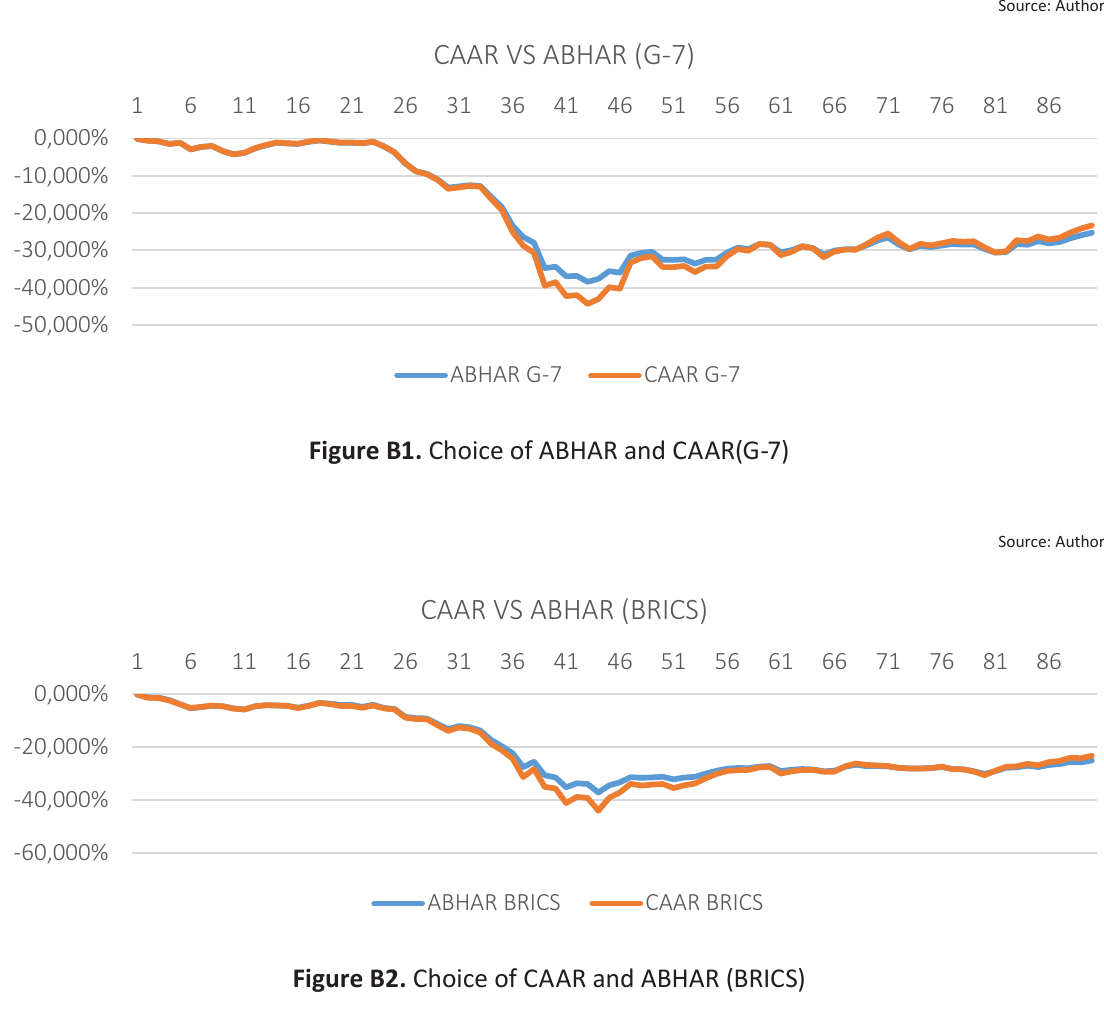
Figure B2. Choice of CAAR and ABHAR